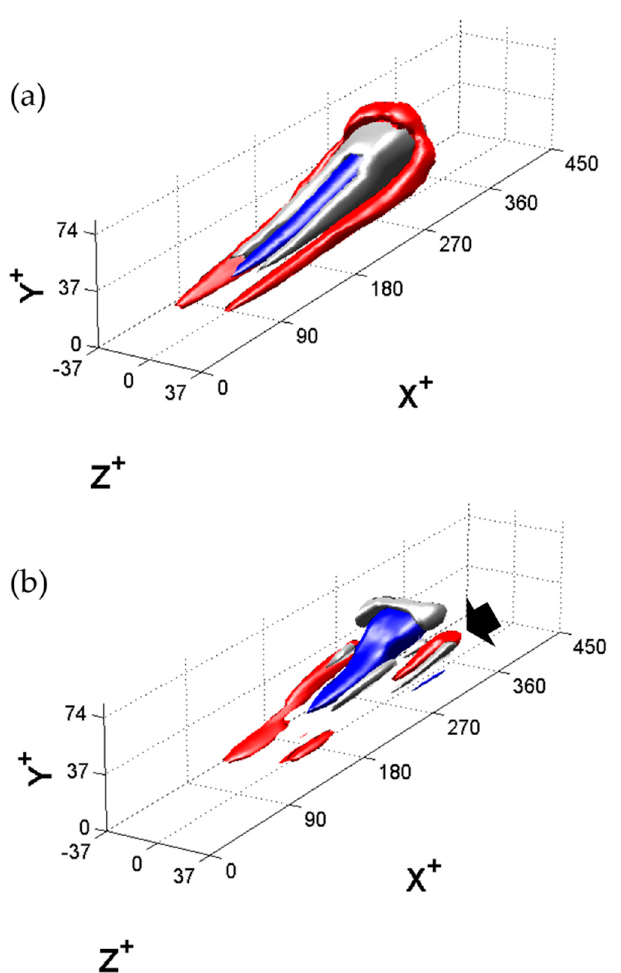
Figure 9. Isosurfaces of ensemble averaged streamwise velocity fluctuations. ( a ) No control and ( b ) control.